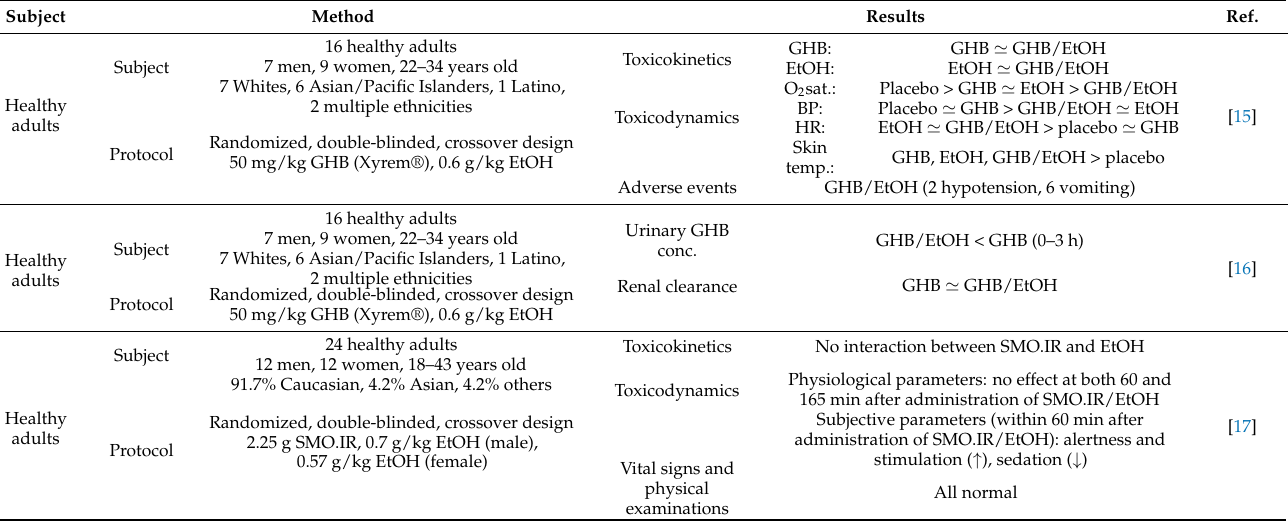
Human studies on toxicokinetic and toxicodynamic changes following gamma- hydroxybutyric acid (GHB) and ethanol